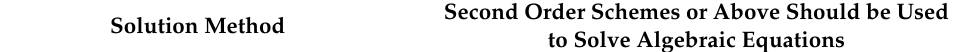
Table 1. Requisites for a consistent computational fluid dynamics (CFD) simulation [46,49,50] as applied on Figure